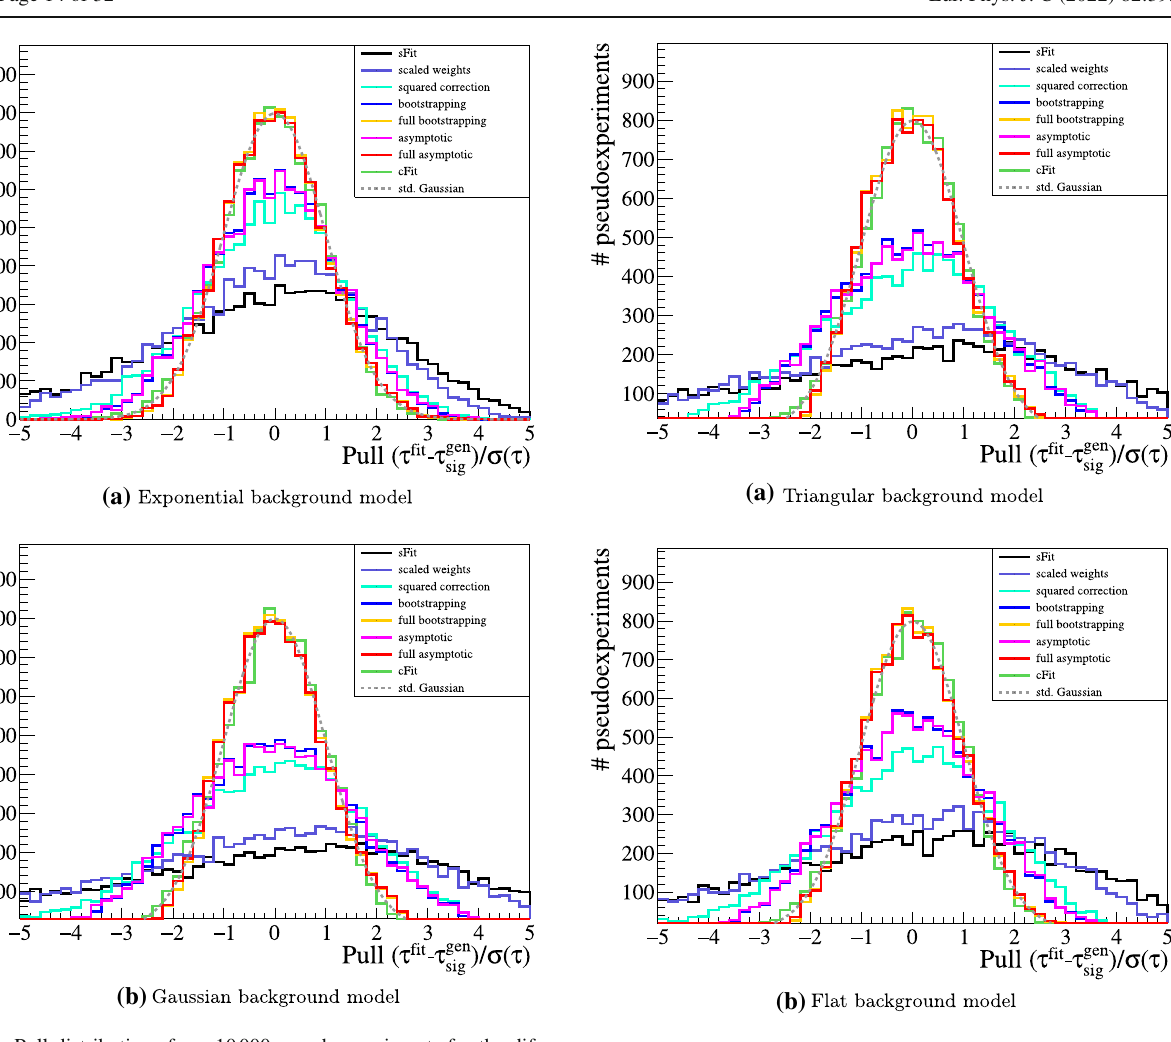
Fig. 9 Pull distributions from 10000 pseudoexperiments for the dif- ferent approaches to the uncertainty estimation for a total yield of 2000 events in each pseudoexperiment. The different figures shown corre- spond to the different background models as specified in Sect.